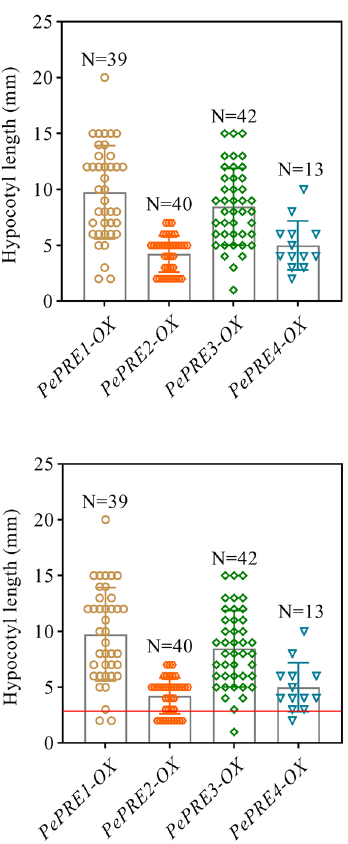
Figure A1. The phenotypes of T1 transgenic plants overexpressing PePRE s in Col-0 background. Overexpression PePRE-GFP caused longer hypocotyls in Col-0. Hypocotyl measurement of light-grown PePRE-GFP transgenic plants compared with Col-0 (the red line indicates the average hypocotyl length of Col-0).